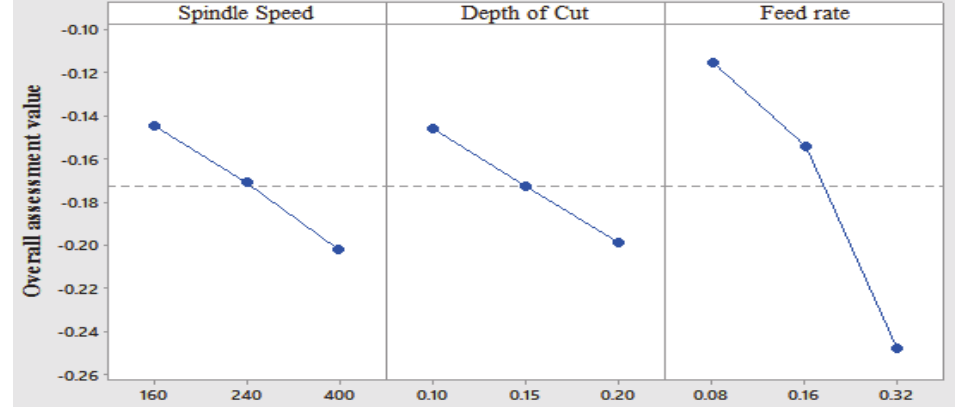
Fig. 6. Overall assessment value graph